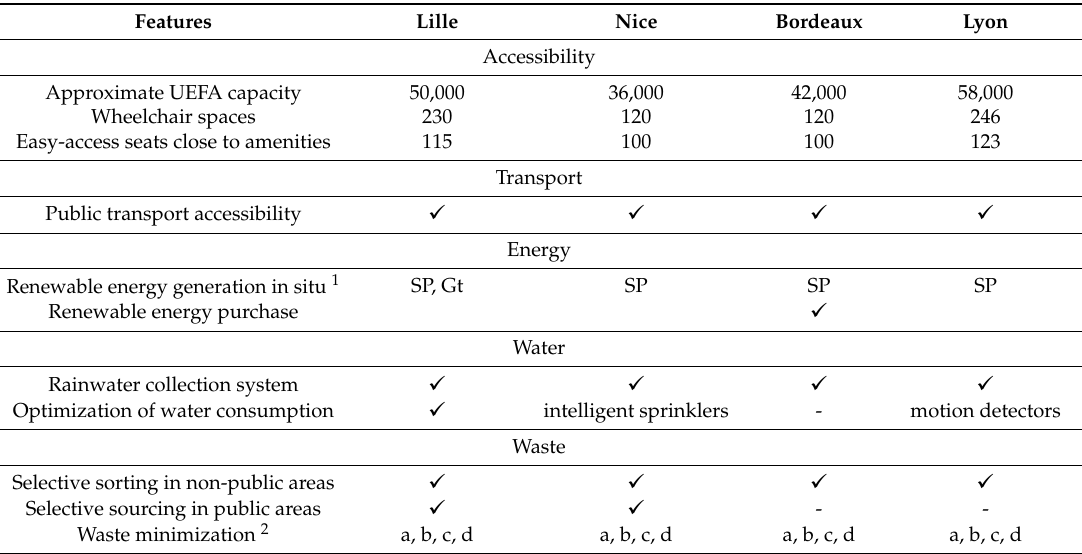
Table 1. UEFA Euro 2016 new arenas’ configuration [47].